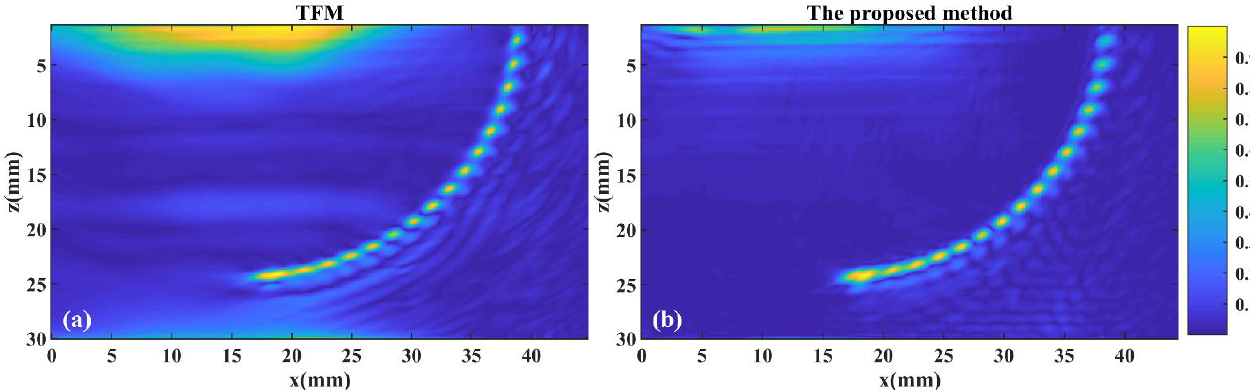
Figure 12. The experimental results of the detection for standard specimen. ( a ) The image reconstructed by TFM. ( b ) The image reconstructed by the proposed method.